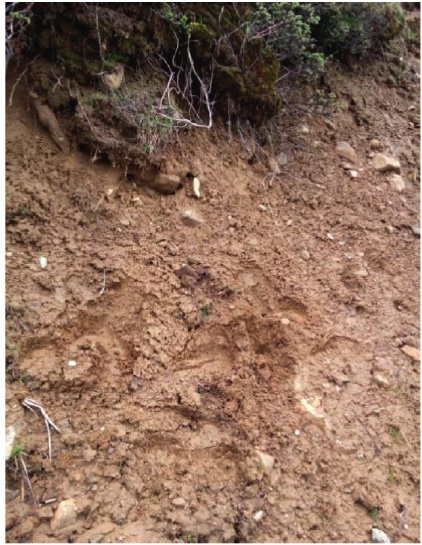
Figure 14: Shallow landslide due to multiple freeze-thaw cycles.